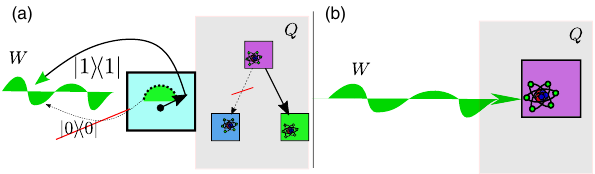
FIG. 2. The picture depicts items 3 and 4 of the elemental operations defining LOP. Item 3, depicted in panel (a), means that to do operations on the quantum state, measure what happens, and use the incoherent basis of the wire to encode the observation is considered to be a classical operation on the wire and, therefore, free. Item 4, depicted in panel (b), means that the wire is effectively treated as a quantum system. This means that it can interact with the quantum system in a quantum way. However, if the wire is an extended object, it might be hard to change its state in a controlled way by this interaction. Therefore it is considered a free operation to forward the state of a subsystem of the wire to the quantum side, but not to alter the state of the wire in a quantum